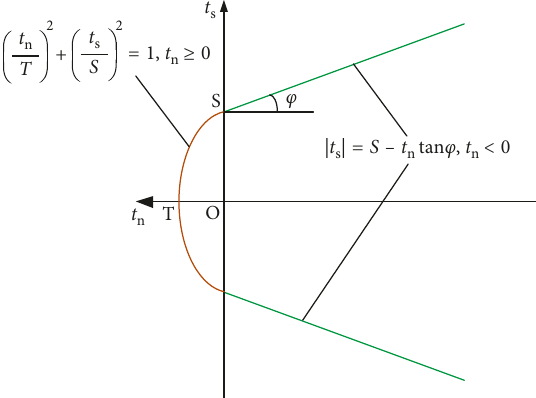
Figure 6: Damage criterion in the t